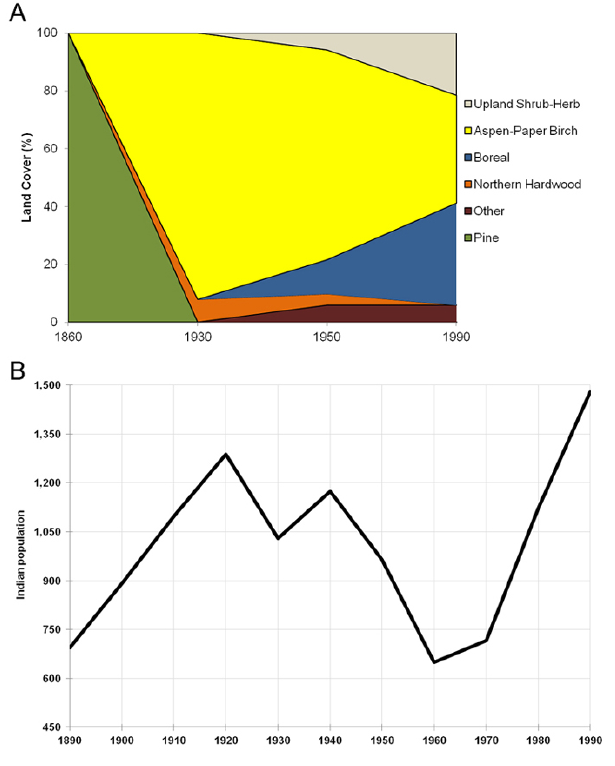
Fig. 7. Coupled human and natural systems elements of the Bad River Indian Reservation, Wisconsin, 1860–1990. (A) Landscape composition: land-cover change of old-growth white pine-dominant stands, 1860–1990. Source: modified from Steen-Adams et al. (2011). (B) Human population,